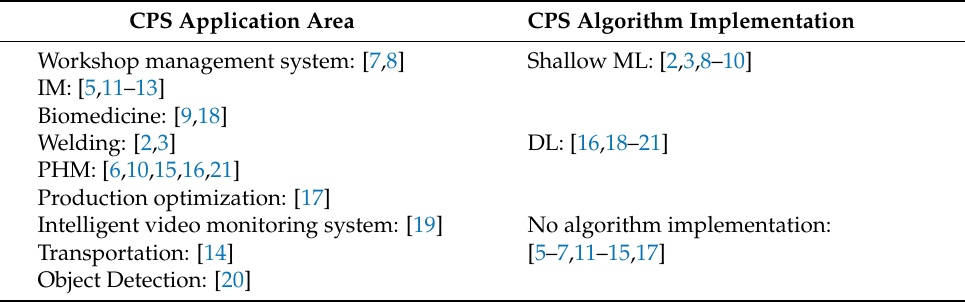
Table 2. The application area and algorithm implementation of